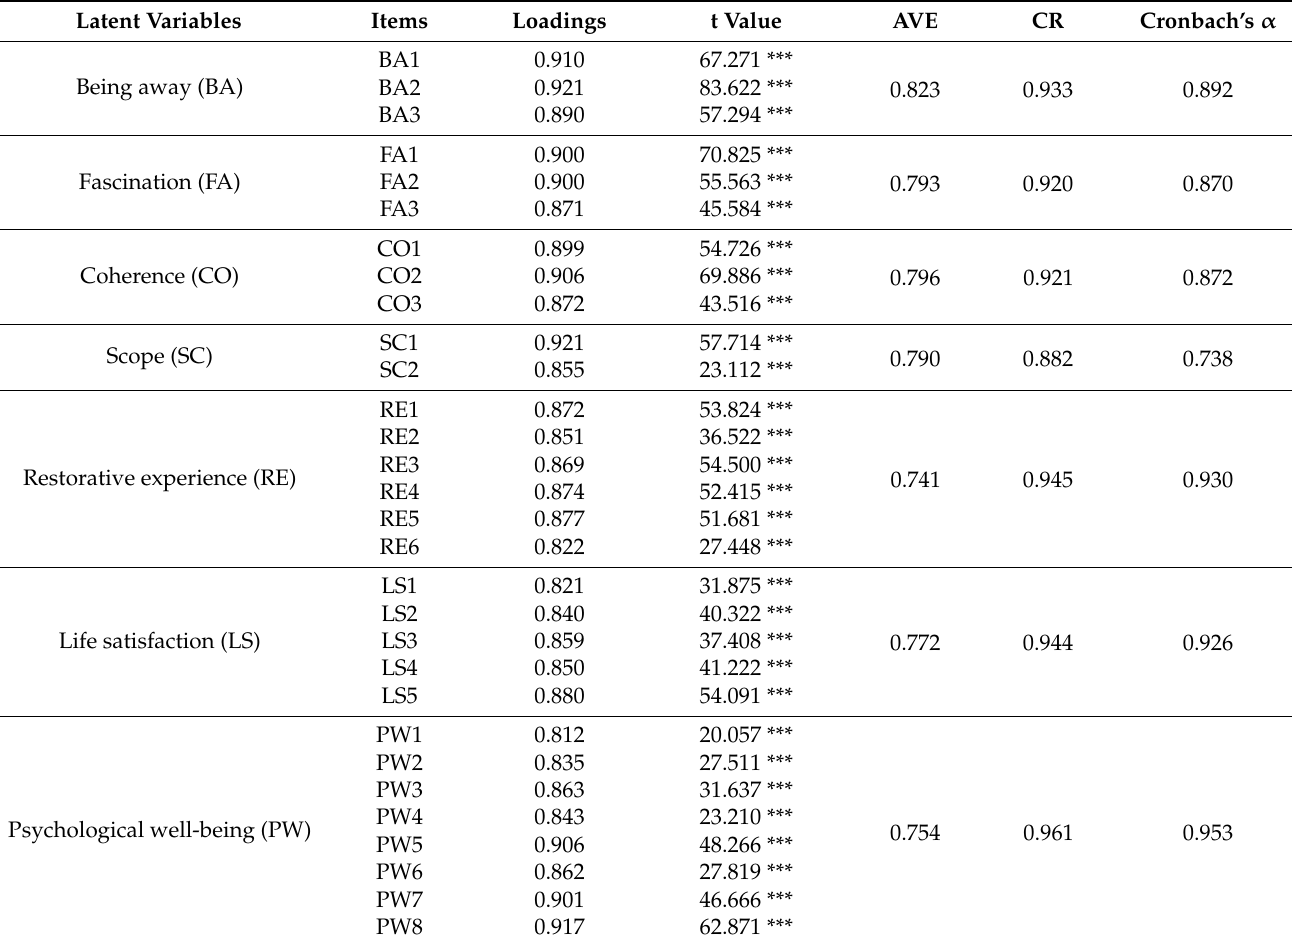
Table 3. The result of convergent validity of constructs.